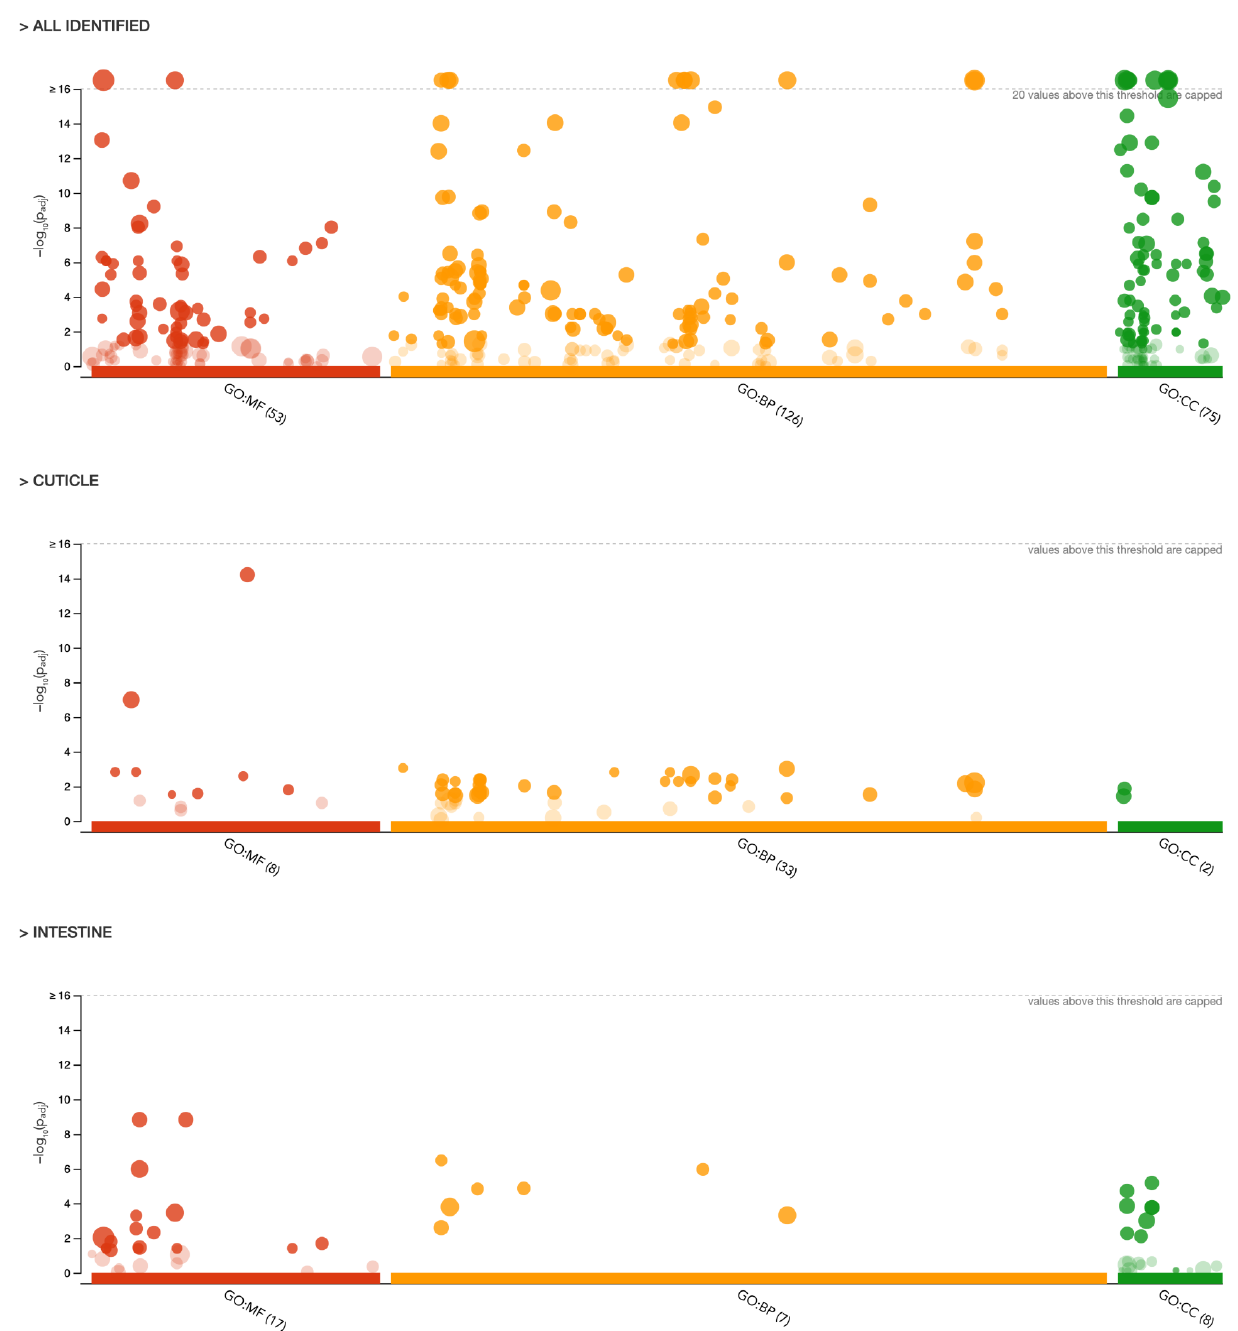
Figure 3. Manhattan plot illustrating the results of the GO analysis. The functional terms are grouped and color-coded by data sources, i.e., molecular function (MF; in red), biological processes (BP; in orange), and cellular components (CC; in green). The five top subcategories from each category are described in Table 1. Detailed representation and annotation of all proteins submitted to the analysis can be found in Files S1 and S2.